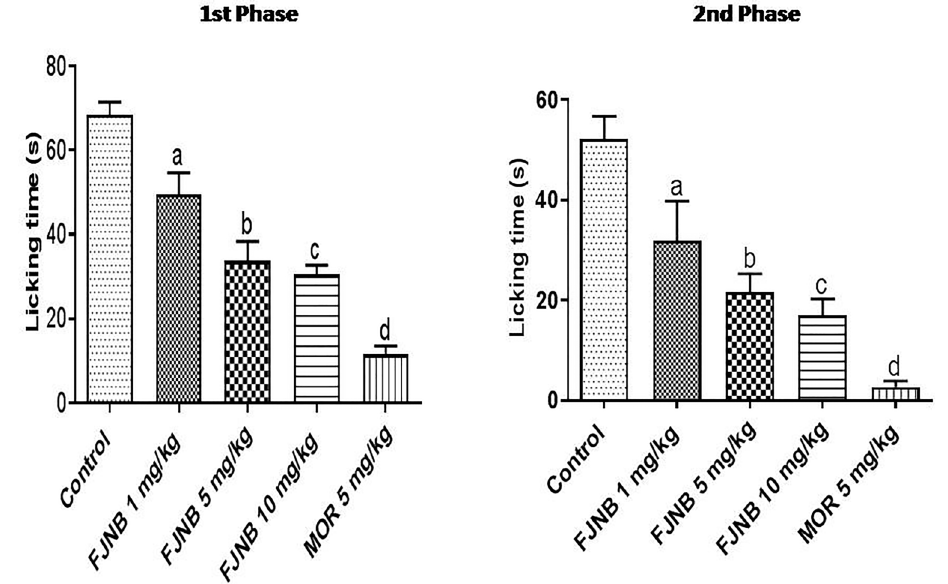
Figure 3. The triterpene-rich fraction from Himatanthus drasticus (FJNB) inhibited the 1st (neurogenic) and 2nd (in fl ammatory) phases of the formalin test in mice. Morphine (MOR) was used as reference. Data are reported as means ± SE. 1st Phase: a P o 0.05, b P o 0.0001, c P o 0.0001, d P o 0.0001 vs Control. 2nd Phase: a P o 0.05, b P=0.0014, c P o 0.0001, d P o 0.0001 vs Control (one-way ANOVA and Tukey ’ s test for multiple comparisons).